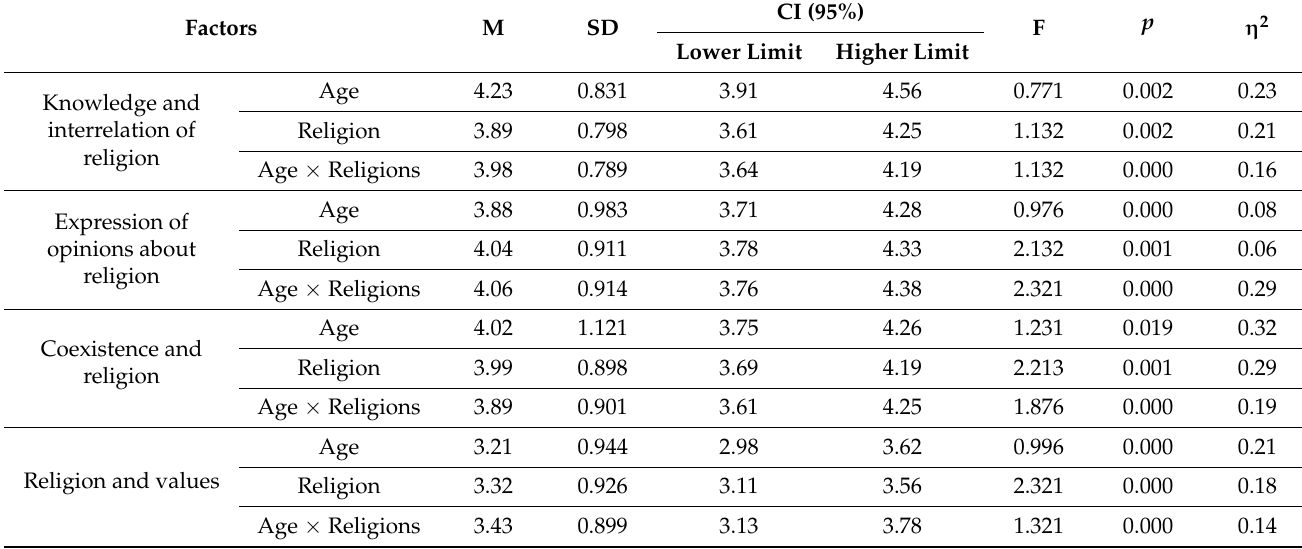
Table 2. ANOVA and effect size ( η 2 ) for the religion, interrelationship and opinion in children and adolescents questionnaire (RIOCAQ). (Sums of aggregated